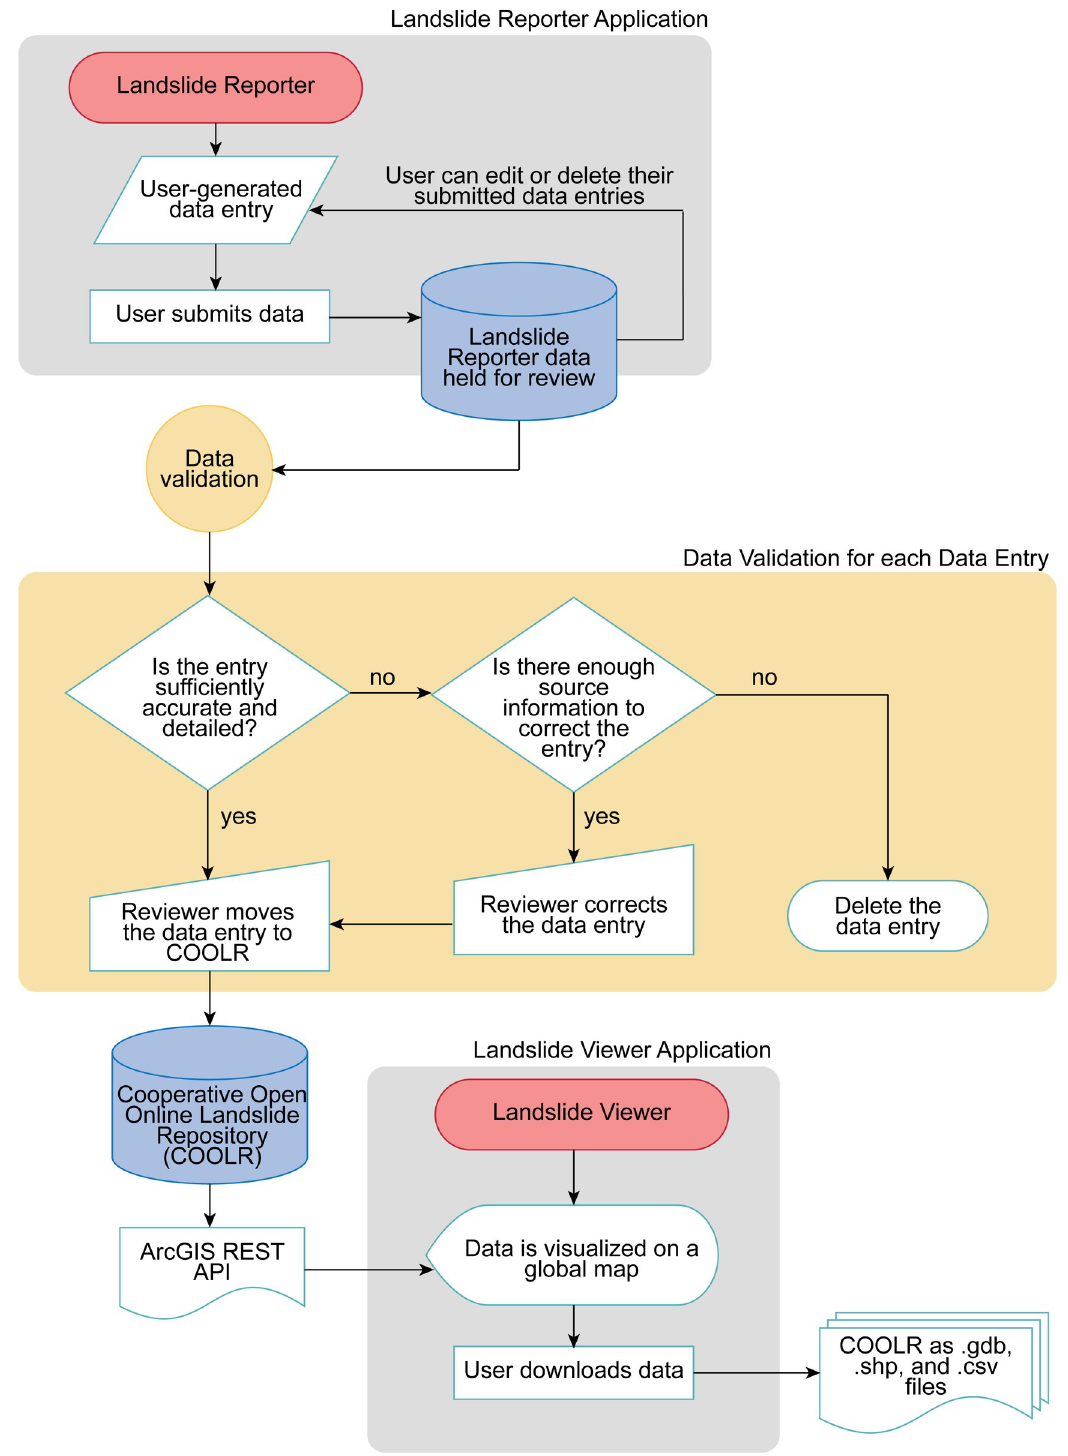
Fig 4. Landslide Reporter submission process. The process is divided into three parts: Landslide Reporter, data validation, and Landslide Viewer. The gray indicates the parts of COOLR’s component web applications that the citizen scientist and the public (the user) can interact with. The yellow indicates the process that a NASA scientist (the reviewer) must conduct in the backend for validating all citizen science data. Landslide Reporter and Landslide Viewer can be accessed independently at any time.